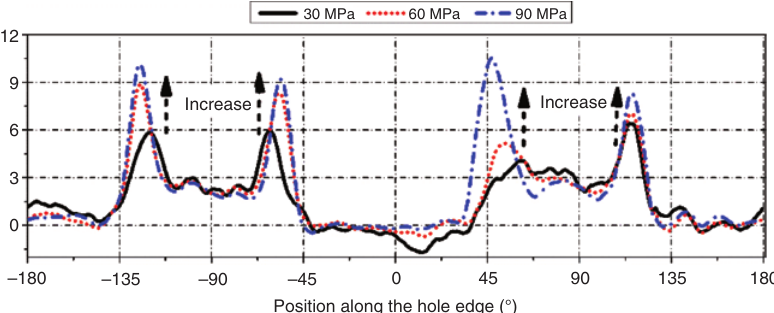
Figure 6: Normalized strain distribution along the edge of the hole under various applied stress (specimen